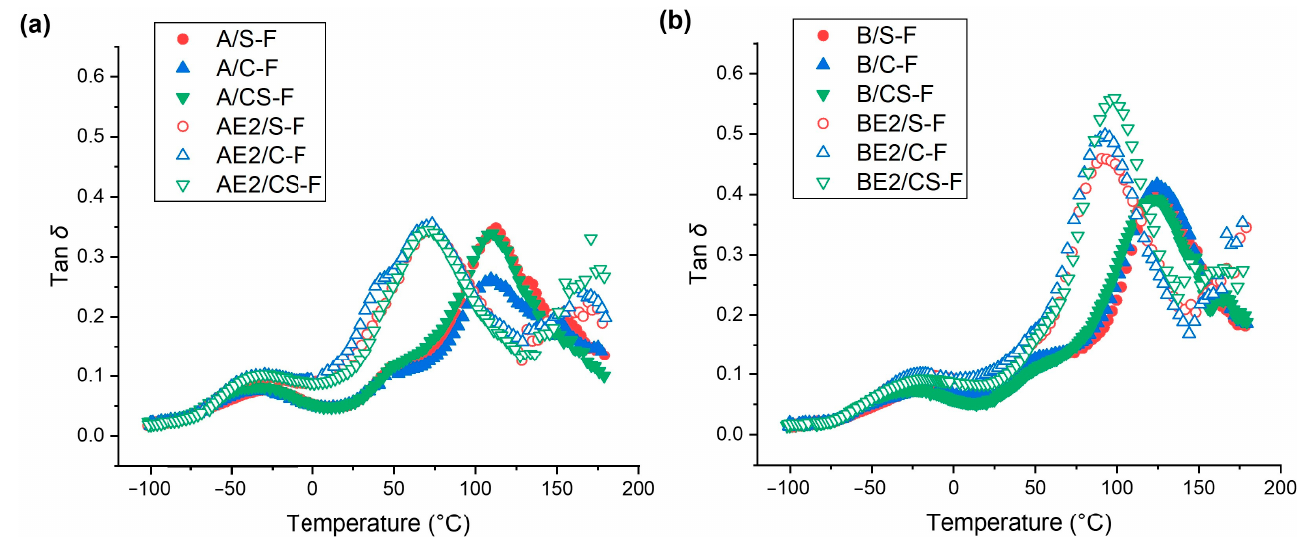
Figure 5. Loss tangent (tan δ ) vs. temperature curves measured by dynamic mechanical thermal analysis (DMTA) for the different bionanocomposite films: ( a ) chitosan matrix; and ( b ) chitosan/CMC matrix.